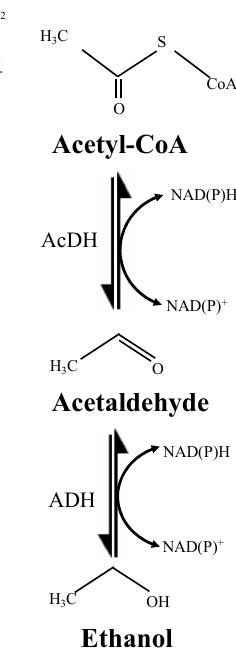
Figure 1. Pathways for ethanol production from pyruvate. Left side, two-step pathways catalyzed by PDC (pyruvate decarboxylase) and ADH (alcohol dehydrogenase); Right side, three-steps path- way catalyzed by POR (pyruvate:ferredoxin oxidoreductase), AcDH (CoA-dependent acetaldehyde dehydrogenase), and ADH (alcohol dehydrogenase).